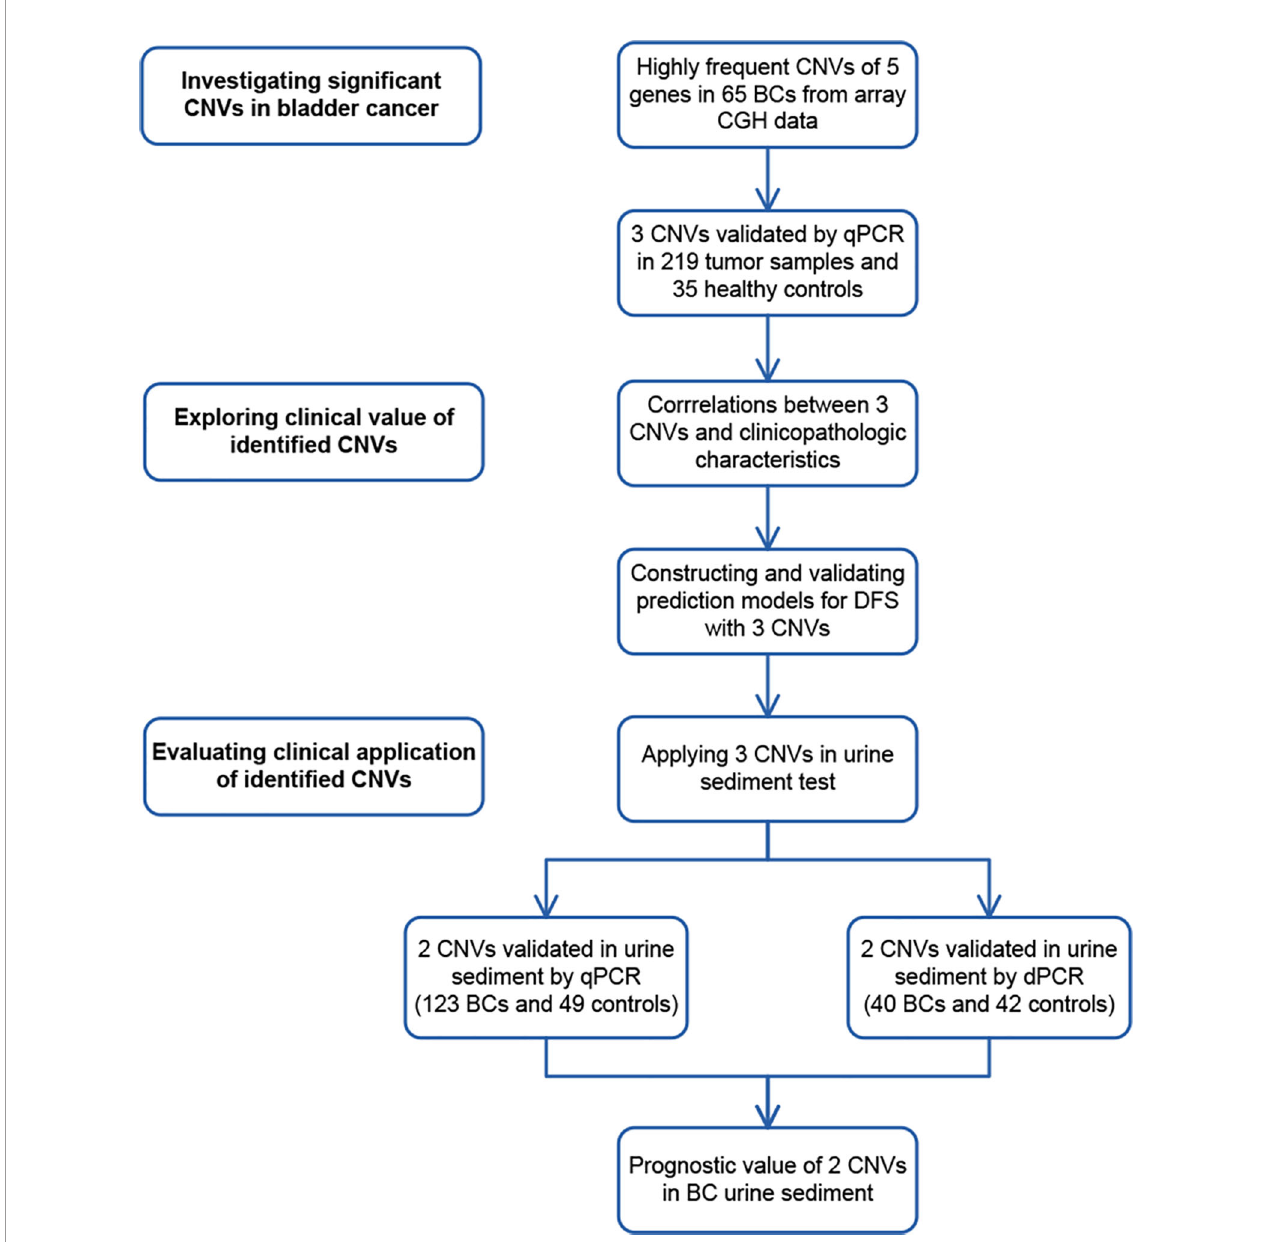
FIGURE 1 | Study design. To discover signi fi cant copy number variations (CNVs), CNVs of 5 genes with high aberration frequencies were selected from array comparative genomic hybridization (CGH) data. Copy number gains of 3 genes were found in tumor samples by real-time PCR (qPCR). To explore their clinical value, correlations between the CNVs of 3 genes and clinicopathological characteristics were analyzed. CNVs of 3 genes were later applied in constructing and validating prediction models in 219 bladder cancer (BC) cases. To evaluate their potential clinical application, CNVs of 2 genes were validated by real-time PCR in 123 BC urine sediment samples and 49 healthy control samples. They were also validated by digital PCR (dPCR) in 40 BC urine and 42 healthy control samples. The prognostic value of 2 CNVs was further assessed in 123 urine